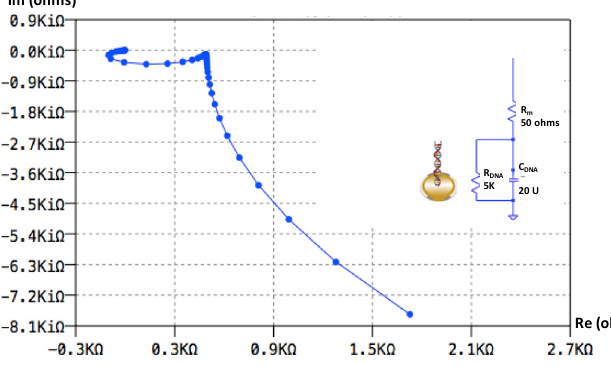
Fig 5. Numerical modelling of a simple DNA molecule anchoring on an electrode surface. Frequency response of the RC equivalent circuit calculated by LTspice